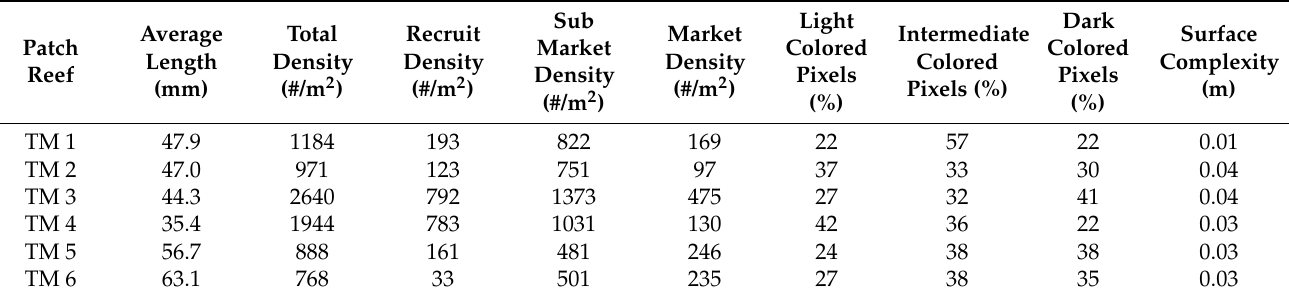
Table 1. Average in situ oyster length, measured as left valve length, density for each size class, spectral and structural metrics calculated for each patch reef located on Town Marsh (TM) and Middle Marsh (MM) that were applied in a series of